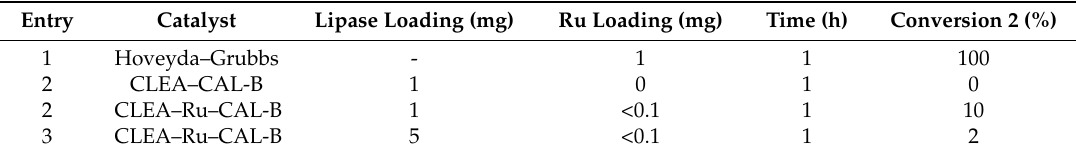
Table 3. Enzyme–Hoveyda–Grubbs second-generation Cross-linked enzyme aggregates (CLEA) conjugate activity in metathesis of 1 .